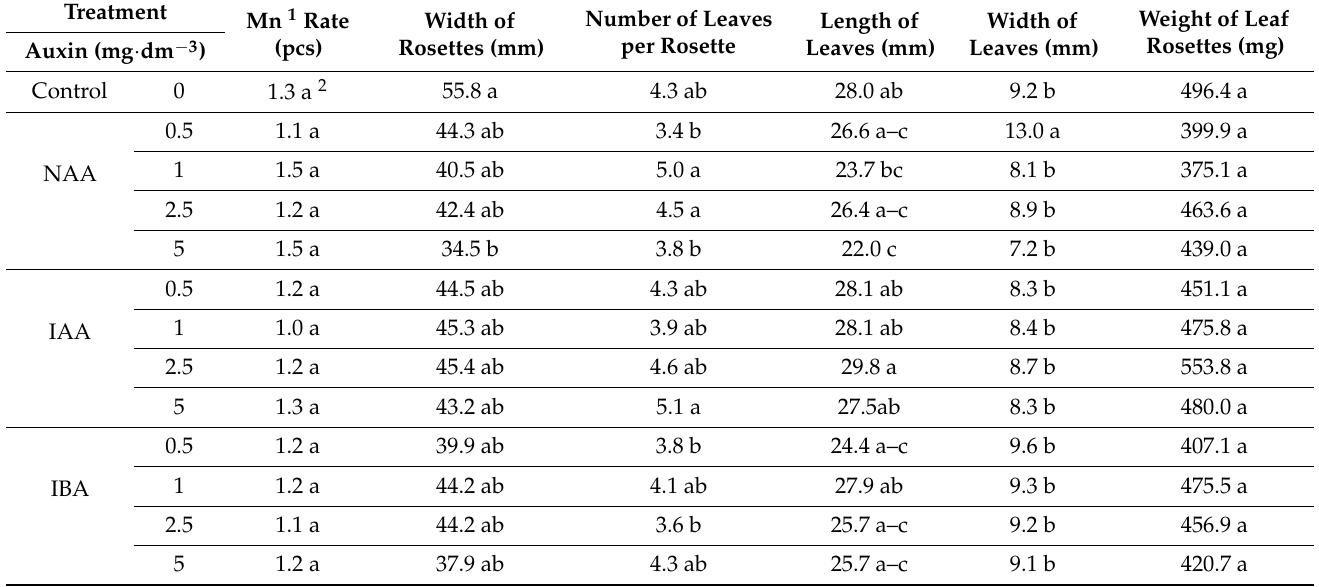
Table 1. The influence of NAA, IAA and IBA auxins on the multiplication rate and morphological features of Paphiopedilum insigne rosettes and leaves in tissue culture.